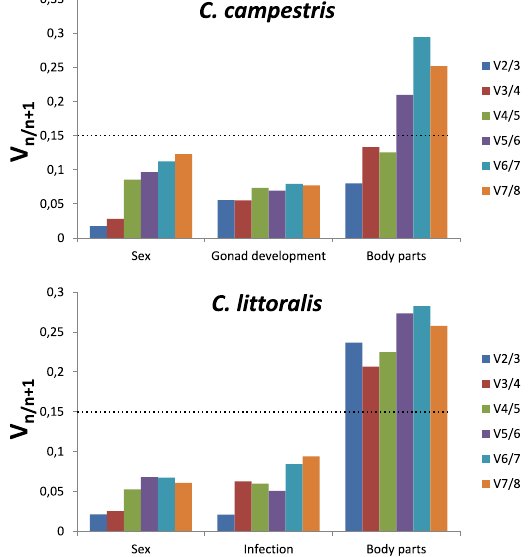
Figure 4. Optimal number of reference genes for normalization in Cicindela campestris and Calomera littoralis . Pairwise variation V n/n + 1 values of candidate reference genes for the different conditions tested in both tiger beetles species were calculated with geNorm software by analysing the parwise variation (V) between the normalization factors NF N and NF N + 1 . Values < 0.15 are indicating that additional genes are not necessary for normalization.